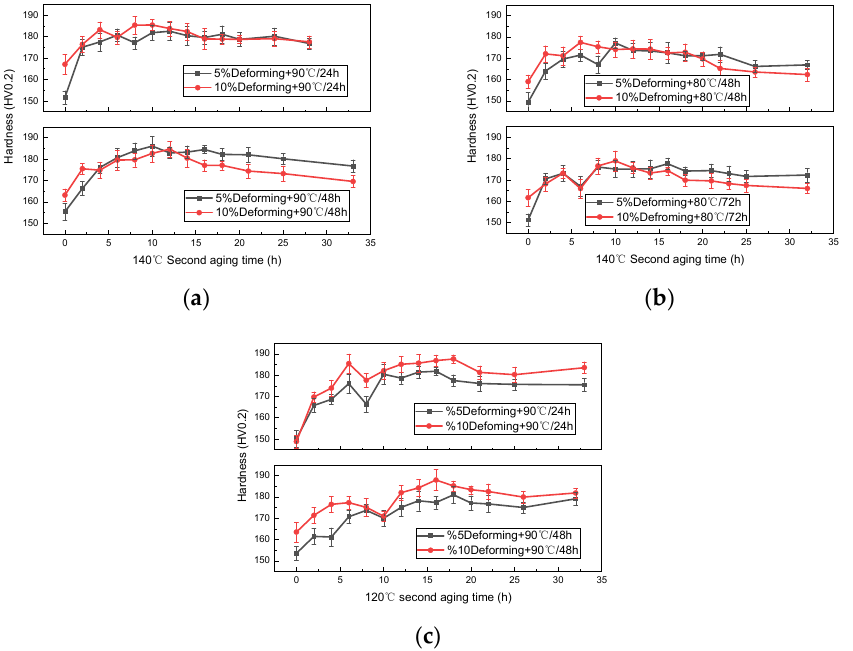
Figure 3. Hardness variation of the FTMT samples with di ff erent fi nal aging times: ( a ) pre-deformation + pre-aging at 90 °C + fi nal aging at 140 °C; ( b ) pre-deformation + 80 °C + 140 °C; ( c ) pre-deformation + 90 °C + 120 °C.